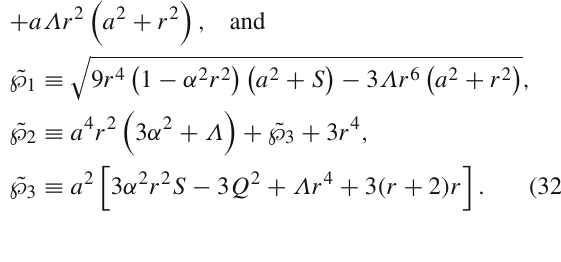
characteristic frequency. The radius r + = M 1 is the BH horizon. The blue line corresponds to r = M 2 . The arrow indicates the increase of frequency